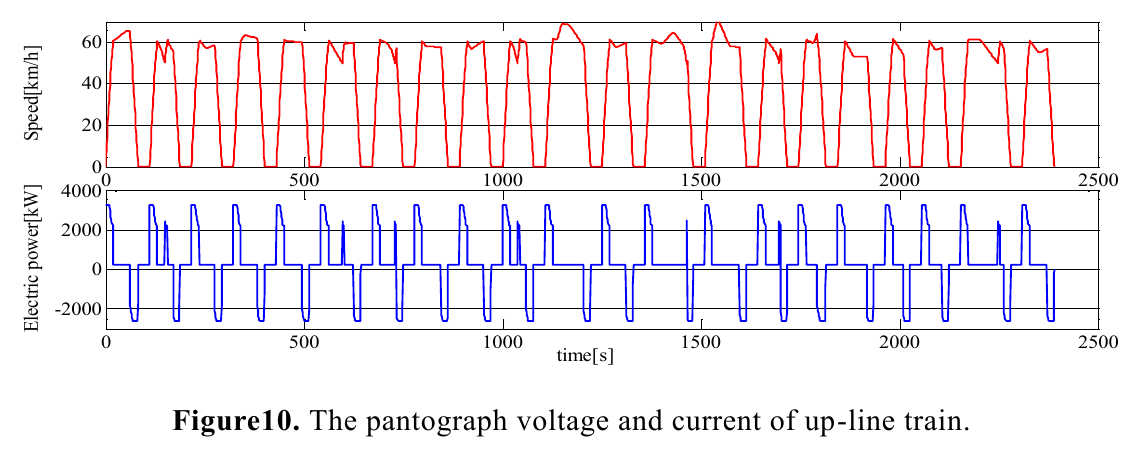
Figure 9. The speed and electric power of up-line train.